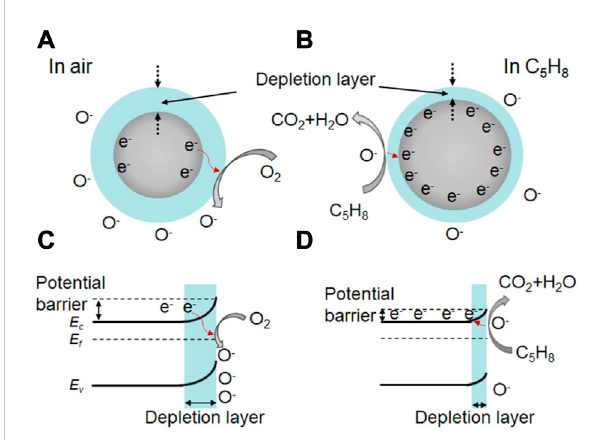
FIGURE 2 (A, B) Schematic diagram of the isoprene sensing mechanism of In 2 O 3 nanostructureat190 ° C,andthecorrespondingbendingofband structures at the surface region of In 2 O 3 nanosturcture (C, D)